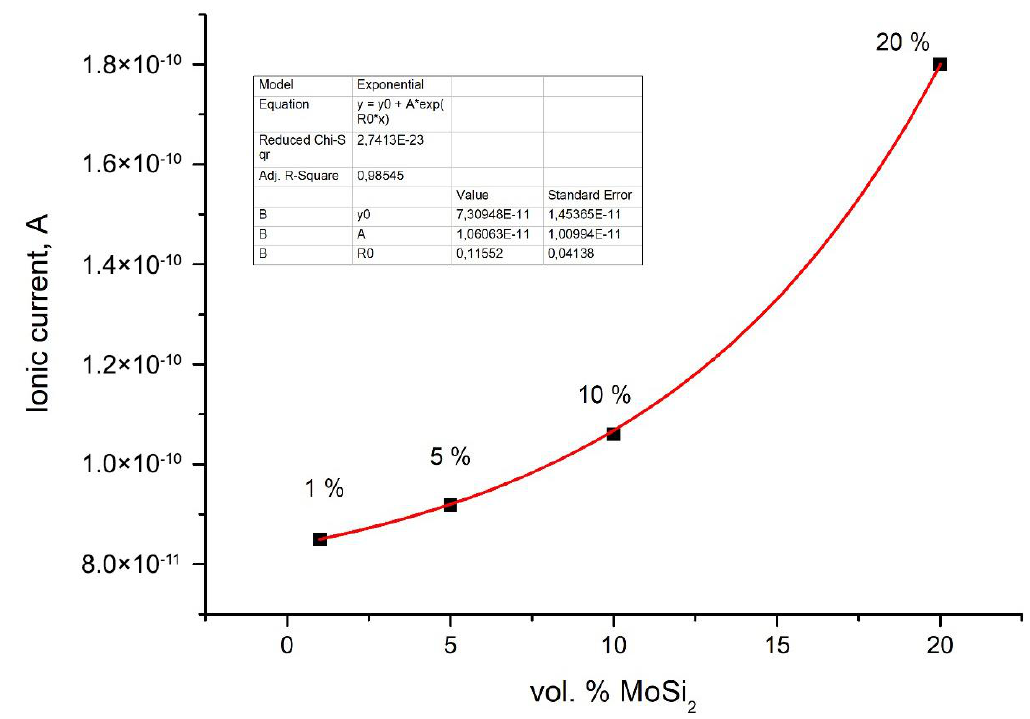
Figure 6. Dependence of the CO 2 main peak intensity on the MoSi 2 concentration.